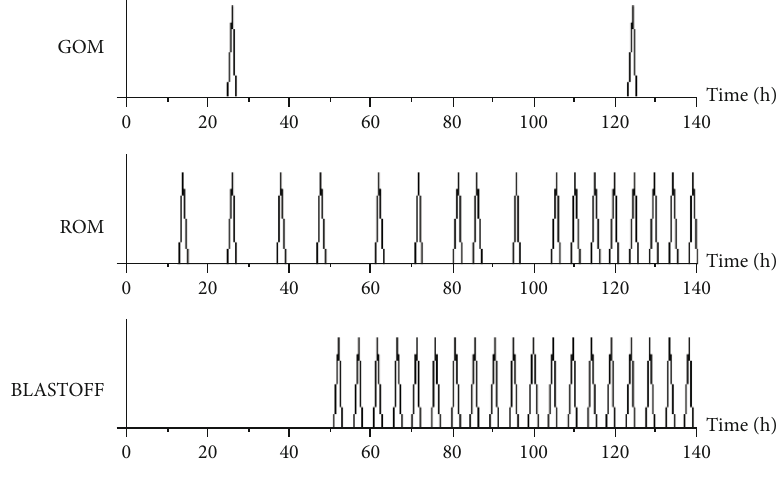
Figure 8: Observation sequences of di ff erent constellations.